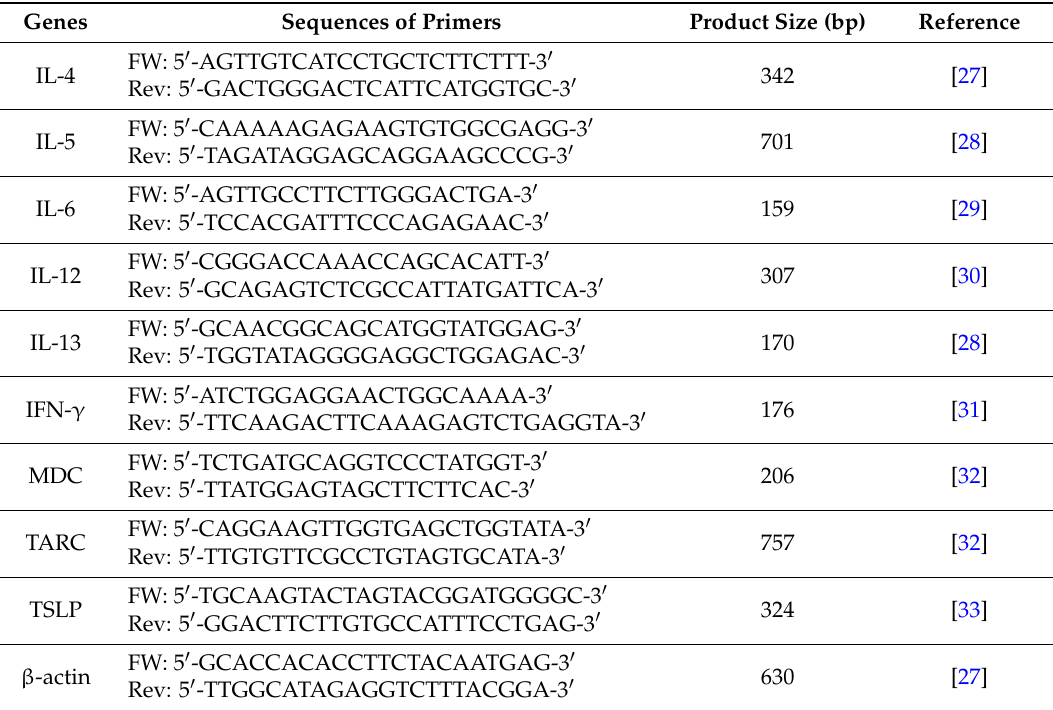
Table 1. The sequences and product size (bp) of